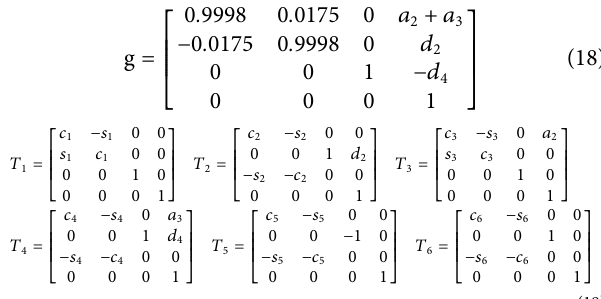
where s i (cid:2) sin θ i ( i (cid:2) 1 ~ 6 ) , c i (cid:2) cos θ i ( i (cid:2) 1 ~ 6 ) . a 1 , a 2 , a 3 , a 6 , d 1 , d 4 , d 6 denotes the parameters of a general six- degree-of-freedom industrial robot arm. g represents the initial position attitude matrix of the end-effector, e ξ 1 θ 1 ~ e ξ 6 θ 6 represents the variation matrix of the joint angles from 1 to 6, α , β , η represents Euler angles of rotation along the x , y , z axes after the end-effector moves from the initial position, and P x , P y , P z represents the new position of the end-effector after the end- effector moves from the initial position. The initial position pose matrix of the robotic arm end-effector in experiment 2, the associated change matrix and the three Euler angles of the end-effector, and the position expressions are shown